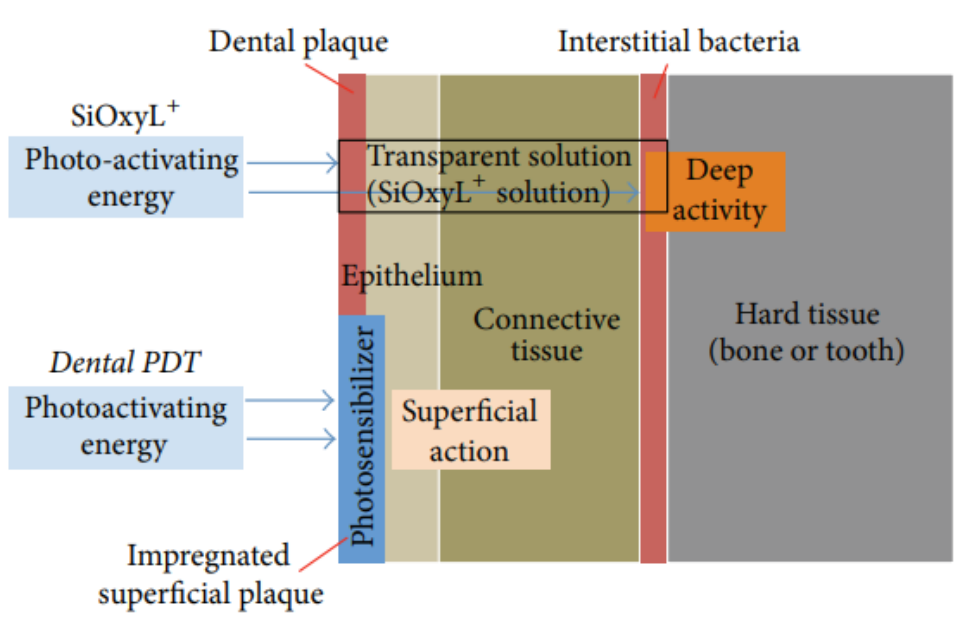
Figure 1. Effects of the transparent photosensitizer.